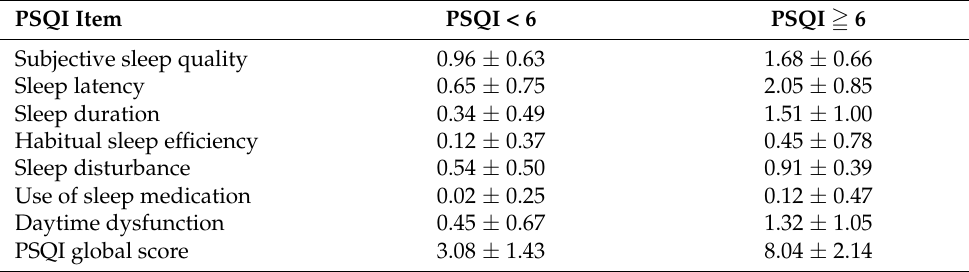
Table 3. Results of the PSQI scores.